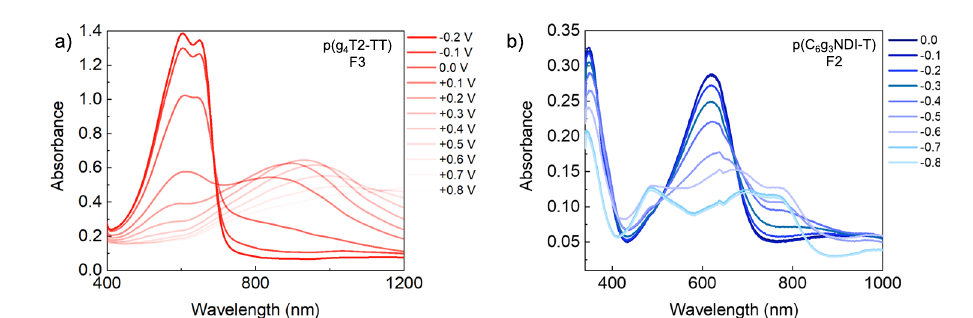
Fig. 3 | Spectroelectrochemical measurements for the highest performing fraction of each polymer. UV-Vis absorption measurements recorded whilst applying a voltage vs Ag/AgCl using a 0.1M NaCl aqueous degassed electrolyte,